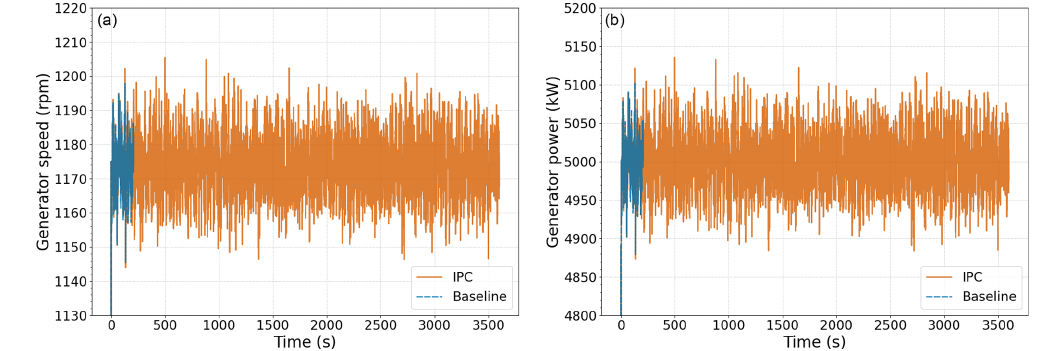
Figure 14. Generator speed (a) and generator power (b) with (solid orange) and without yaw-by-IPC loop (dashed blue) and turbulent mean wind speed of 20ms − 1